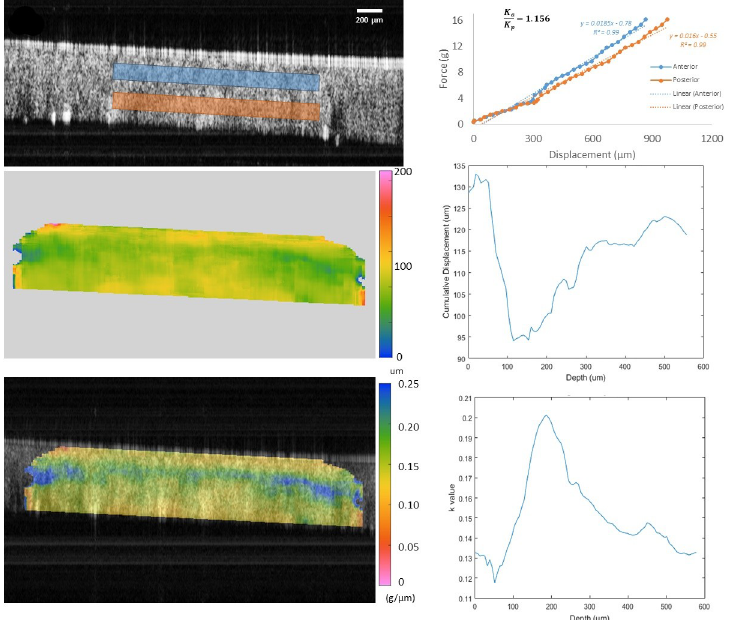
Fig 2. Example OCT elastography results for the right eye of patient one. Top left: Frame of the point of maximum compression. Anterior (blue box) and posterior (red box) stromal regions of interest were defined to generate the force/displacement relationships on the right. Note that the corneal epithelium was intact in all eyes (visible in top left frame) and was included in all analyses except the anterior/posterior stromal region comparisons. Top right: Force vs. displacement plot depicting differences in axial stiffness approximations for the anterior and posterior stromal regions. Higher slopes are consistent with stiffer behavior. Middle Left : Cumulative displacement map of the central cornea in microns. Middle Right: Depth-dependent cumulative displacement profile along a central 100um wide band (averaged laterally) through the depth of the cornea. Bottom left: Elastography map overlaid with the corneal image of the point of maximum compression presenting local values for the slope of the force (grams) vs. displacement ( μ m) relationship, an approximation of axial/compressive stiffness. Cooler colors indicate higher approximate stiffness corresponding to smaller displacement magnitudes than warmer colors. Bottom right: Depth-dependent k profile, representing the approximate stiffness behavior along a central 100um-wide band (averaged laterally) through the depth of the